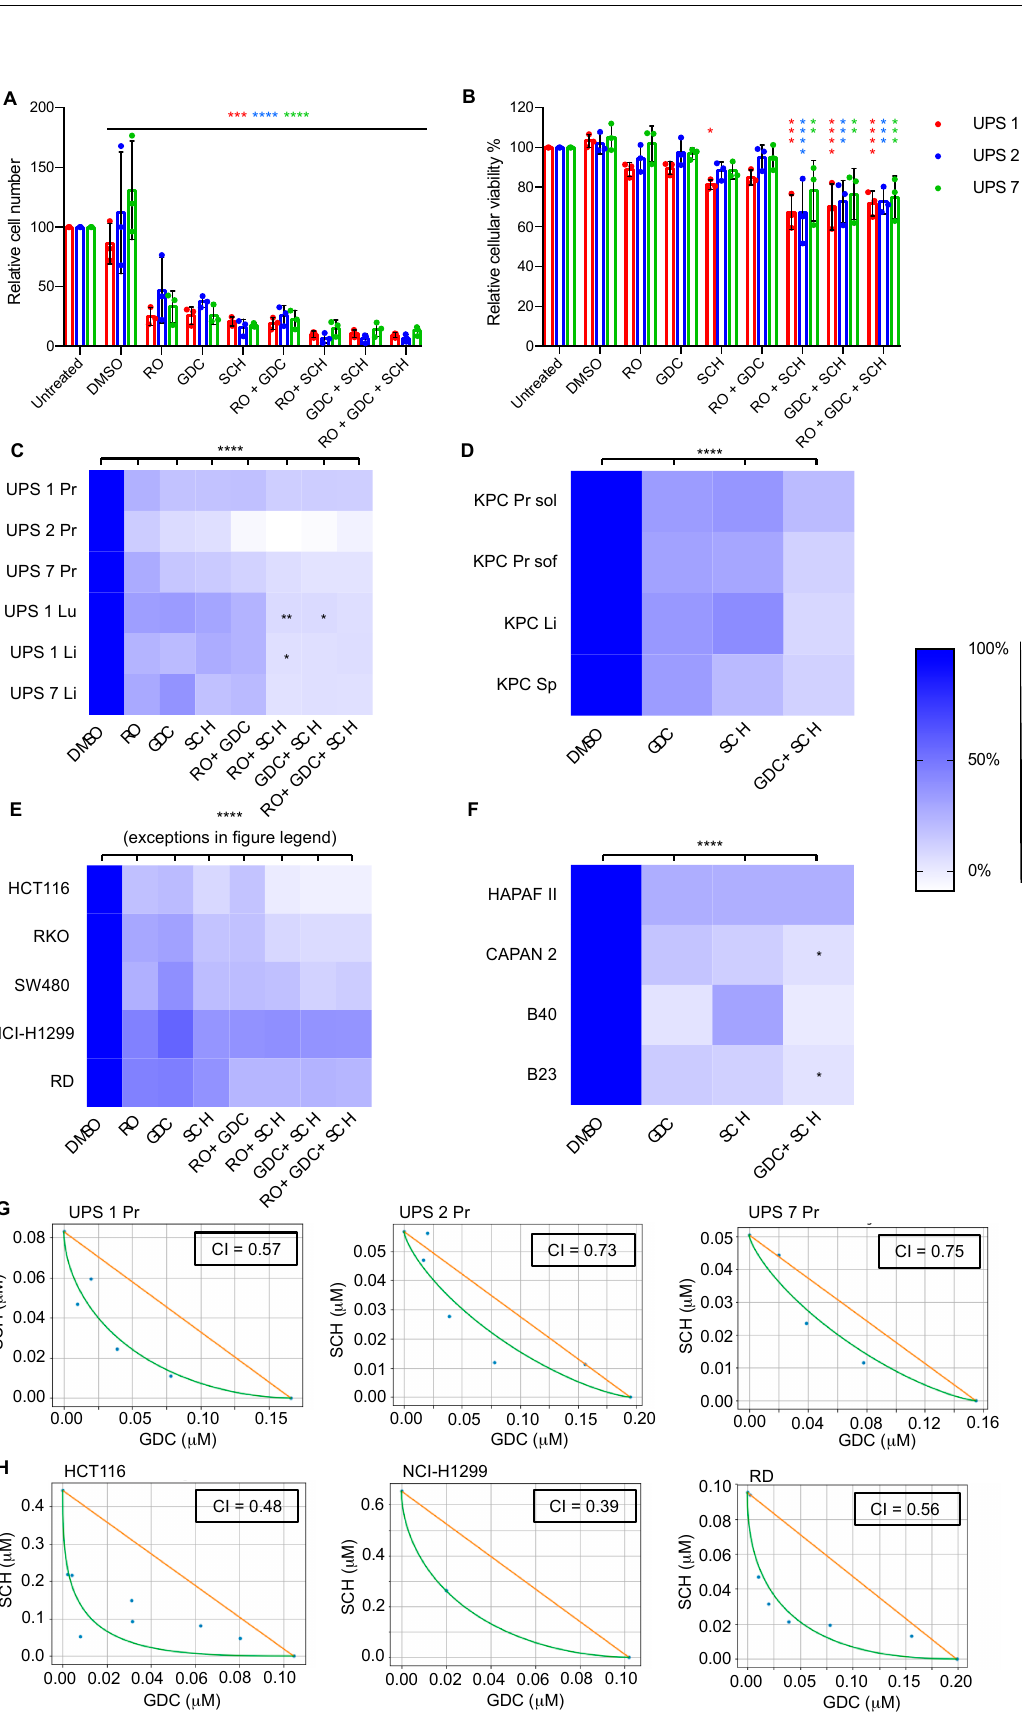
Figure 3. Oncogenic RAS-driven mouse and human cancer cell lines are sensitive to dual MEKi and ERKi treatment. ( A , B ). Relative cell number ( A ) and cellular viability ( B ) assessed on day three of treatment of the indicated UPS cell lines with the